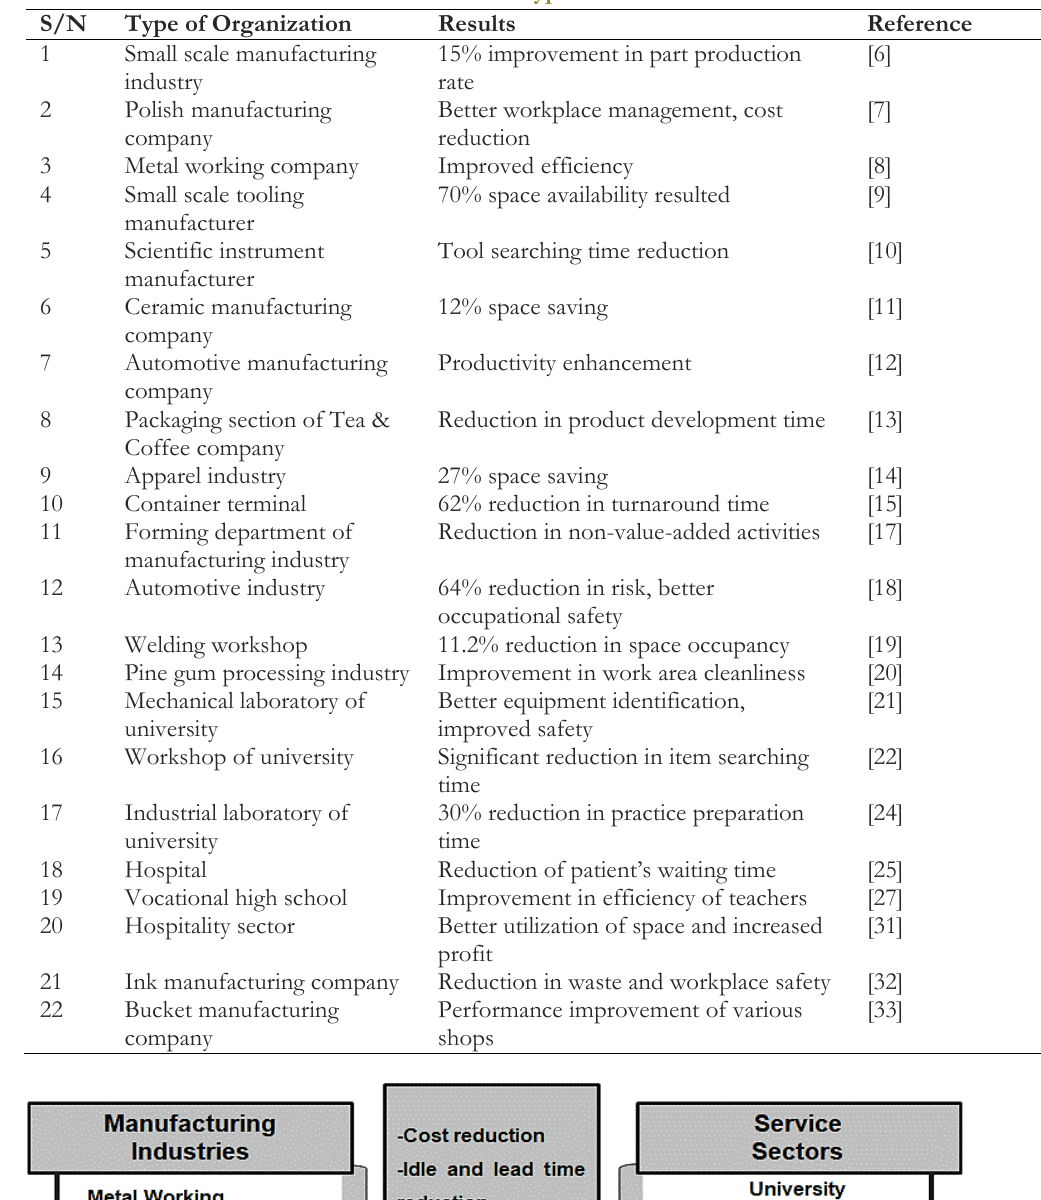
Table 1. Literature review on implementation effects of 5S in various organization